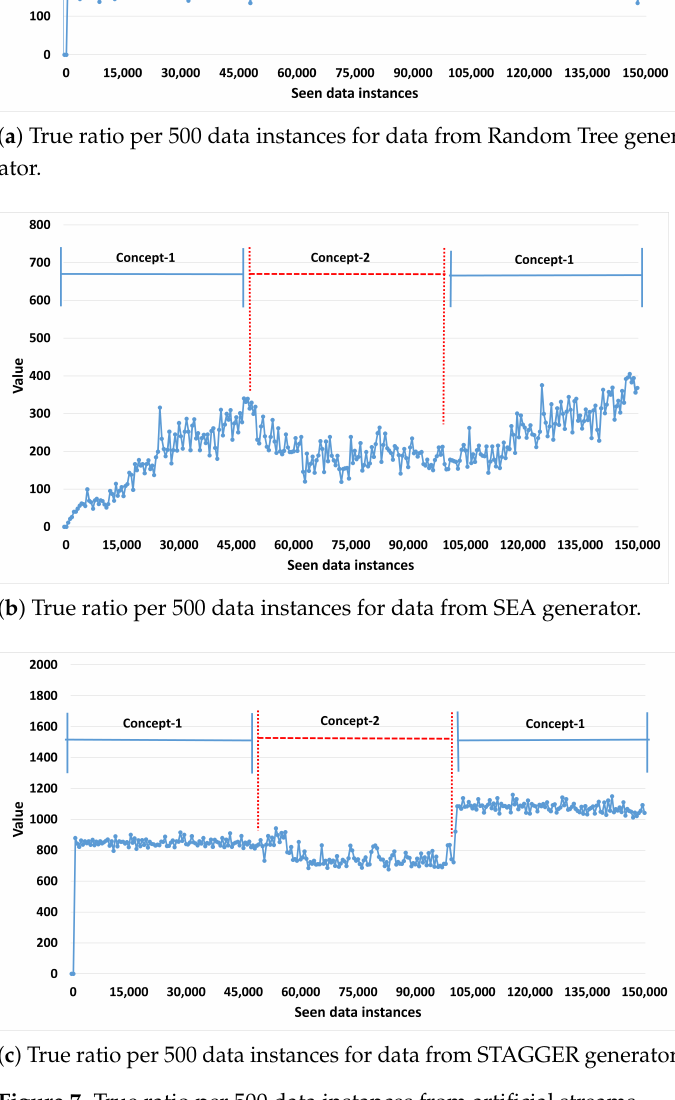
Figure 7. True ratio per 500 data instances from artificial